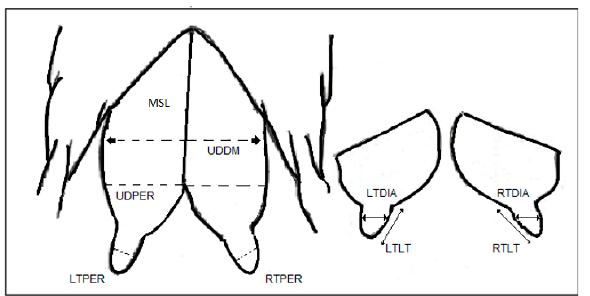
Figure 2. Morphological udder response variables considered: udder perimeter (UDPER, cm), udder diameter (UDDIA, cm), left-teat perimeter (LTPER, cm), right-teat perimeter (RTPER, cm), left-teat length (LTLT, cm), right-teat length (RTLT, cm), left-teat length diameter (LTDIA, cm), right-teat diameter (RTDIA, cm), and medium suspensory ligament (MSL, cm) registered from crossbred dairy goats (Alpine–Saanen–Nubian x Criollo; n = 15) in Northern Mexico (25° N).